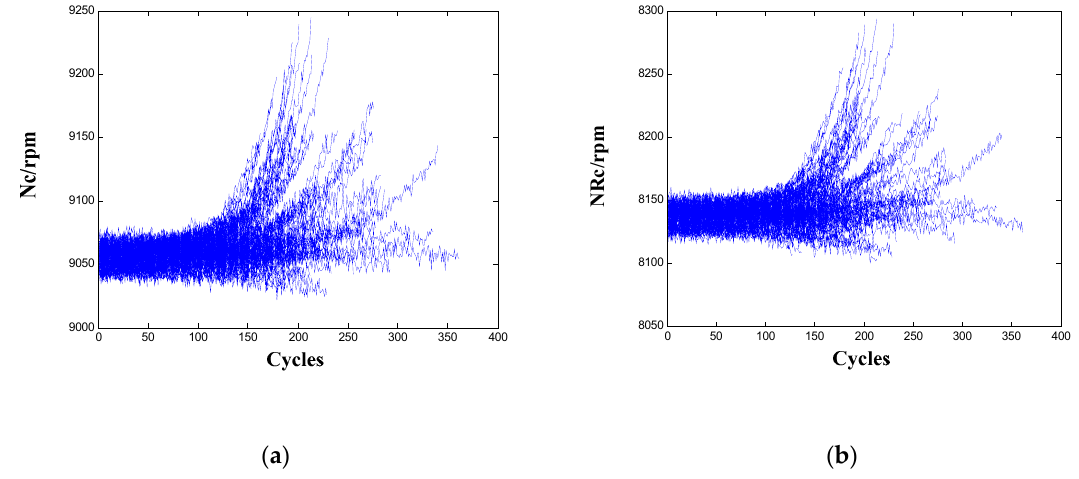
Figure 3. Sensor signals for the 100 training engines: ( a ) Nc; ( b ) NRc.